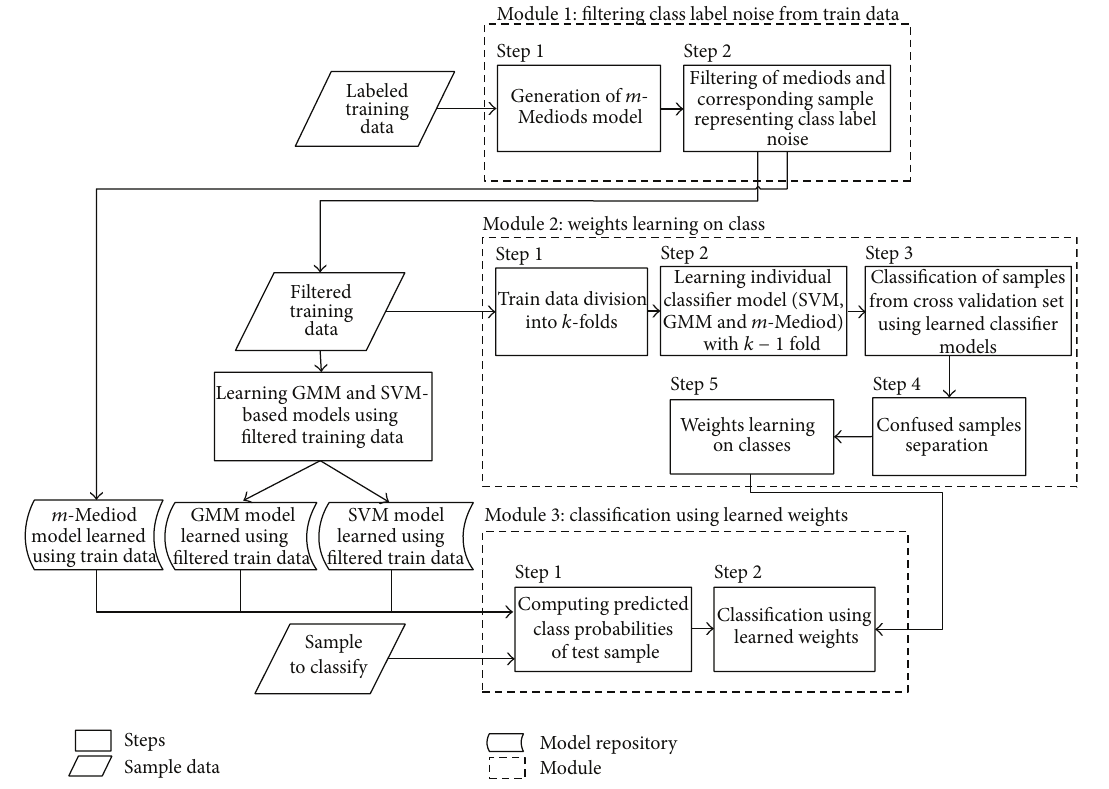
Figure 1: Overview of our proposed framework of classifier